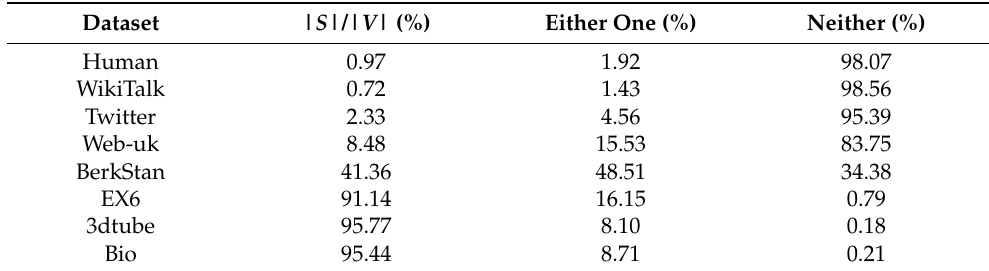
Table 1. The ratio of vertex cover size, | S |, over the number of vertices in the given graph, G = ( V , E ) (column 2), and the probability that one or both query vertices do not belong to S with the assumption that a query is generated by randomly sampling vertex pairs (columns